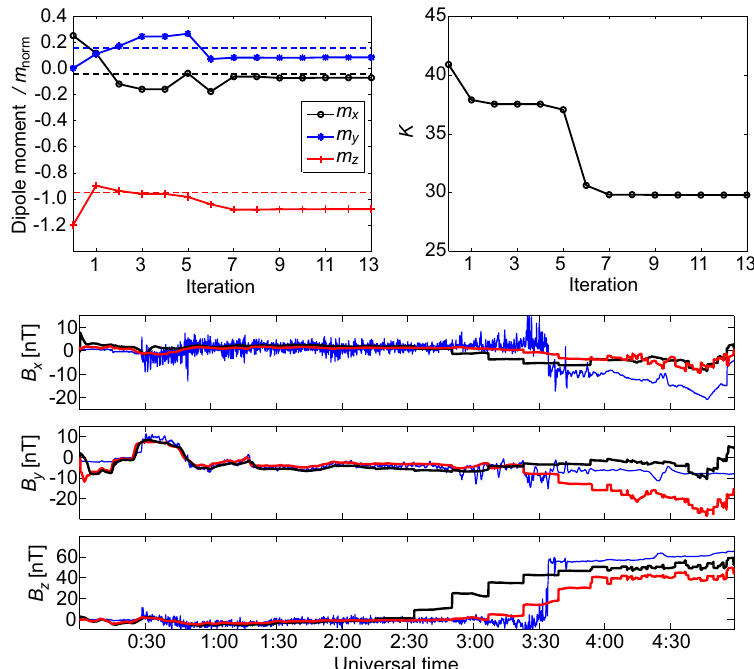
Figure 8. Estimation of Earth’s dipole moment from magnetosheath data of THC on 24 August 2008 using the THB solar wind observations, which are presented in Fig. 3. The variations in the dipole moment during the iteration process (top left) and the corresponding values of the cost function (top right) are shown. The values of the dipole moment of Earth are sketched as dashed lines. The plot on the bottom shows the iterative assimilation of the MHD simulation to the THC data (blue) before the first iteration (black) and after the 13th iteration